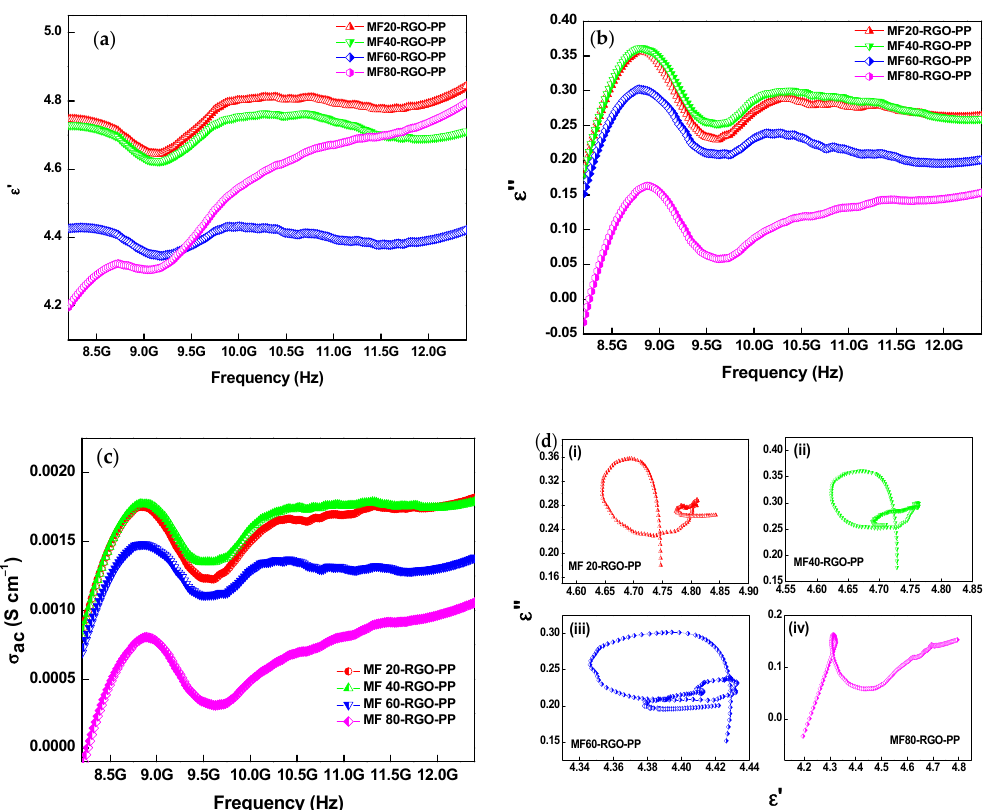
Figure 13. Frequency-dependent ( a ) real permittivity ( ε ’), ( b ) imaginary permittivity ( ε ″ ), ( c ) ac conductivity ( σ ac ) and ( d ) Cole–Cole semicircles ( ε ′ vs. ε ′′ ) of prepared MF20-RGO-PP, MF40-RGO- PP, MF60-RGO-PP and MF80-RGO-PP composite samples.